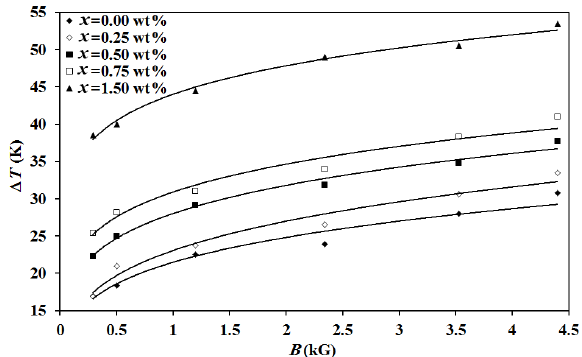
Fig. 8 Relation between transition width and applied magnetic field for (BaSnO 3 ) x /BiPb-2223 samples.